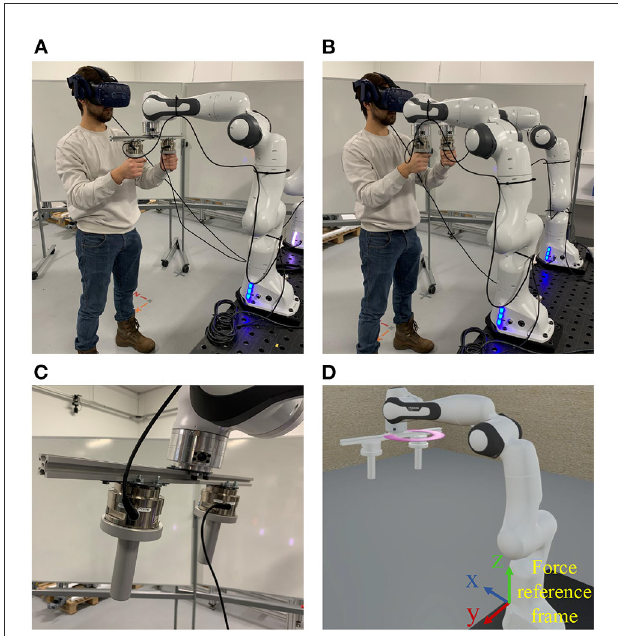
FIGURE10 The real experiment setup (A) and the emulated experiment setup (B) of a physical human-robot co-manipulation of an aluminum bar (C) in the user study. Subjects operated the two setups to make the end-effector of a virtual robot in the same VR scene (D) move along the purple circle for four cycles at as constant speed as possible in the comparative experiments.